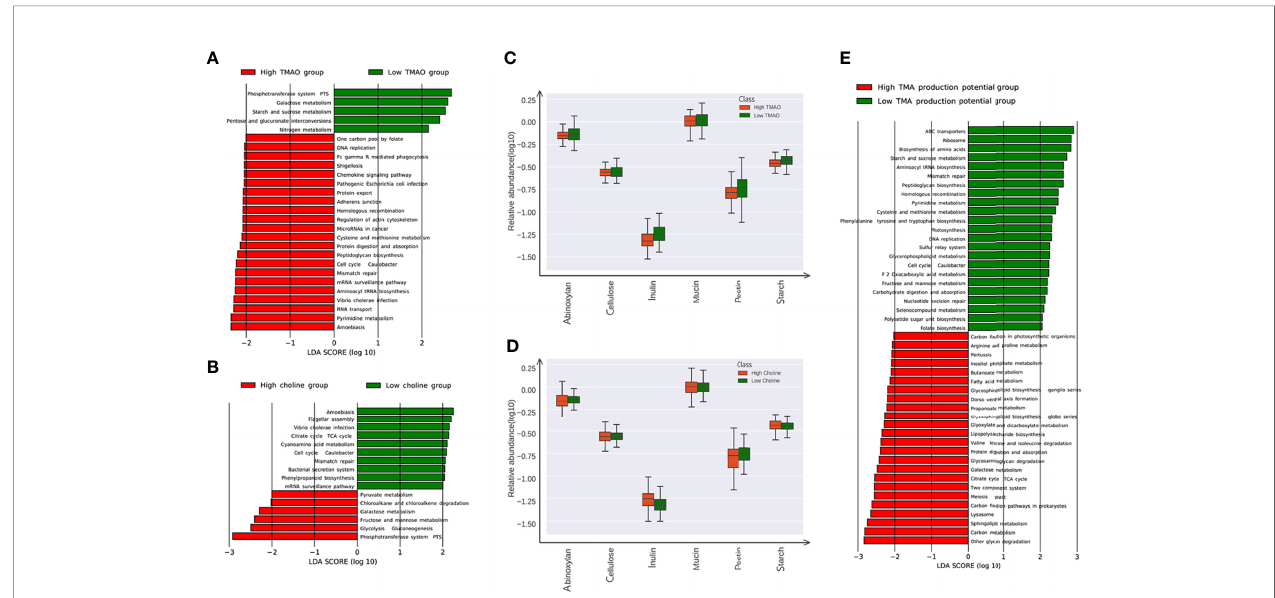
FIGURE 4 | Microbial gene functions annotation in the low (lower thirds) and high (higher thirds) TMAO/Choline groups. (A) The average abundance of KEGG modules differentially enriched in gut microbiome of the low and high TMAO groups. Five modules enriched in low TMAO group, and 22 modules overrepresented in high TMAO group are shown in green and red, respectively. (B) The average abundance of KEGG modules differentially enriched in gut microbiome of low and high choline groups. Five modules enriched in low choline group, and twenty twou modules overrepresented in high choline group are shown in green and red, respectively. (C) The average abundance of CAZy family involved in metabolism of inulin, pectin, and starch signi fi cantly altered in the low and high TMAO groups. (D) The average abundance of CAZy family involved in metabolism of inulin signi fi cantly altered in the low and high choline groups. (E) The average abundance of KEGG modules differentially enriched in gut microbiome of groups with the low and high TMA production potential. 23 modules enriched in low TMA production potential group, and 24 modules overrepresented in high TMAO group are shown in green and red,